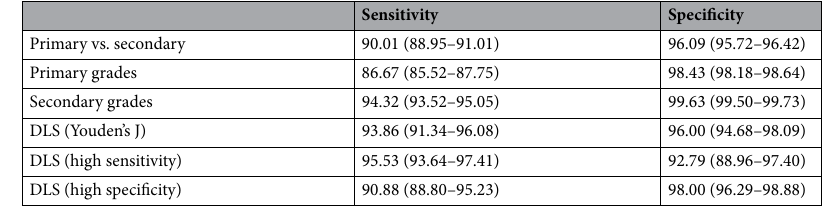
Table 2. Intergrader and algorithm performance at different operating points. For intergrader agreement on referable DR detection, gradable person eyes for both primary and secondary graders are considered. In all cases, with the exception of Primary vs. Secondary intergrader assessment, Primary and secondary grade agreement with the reference standard (after arbitration) is